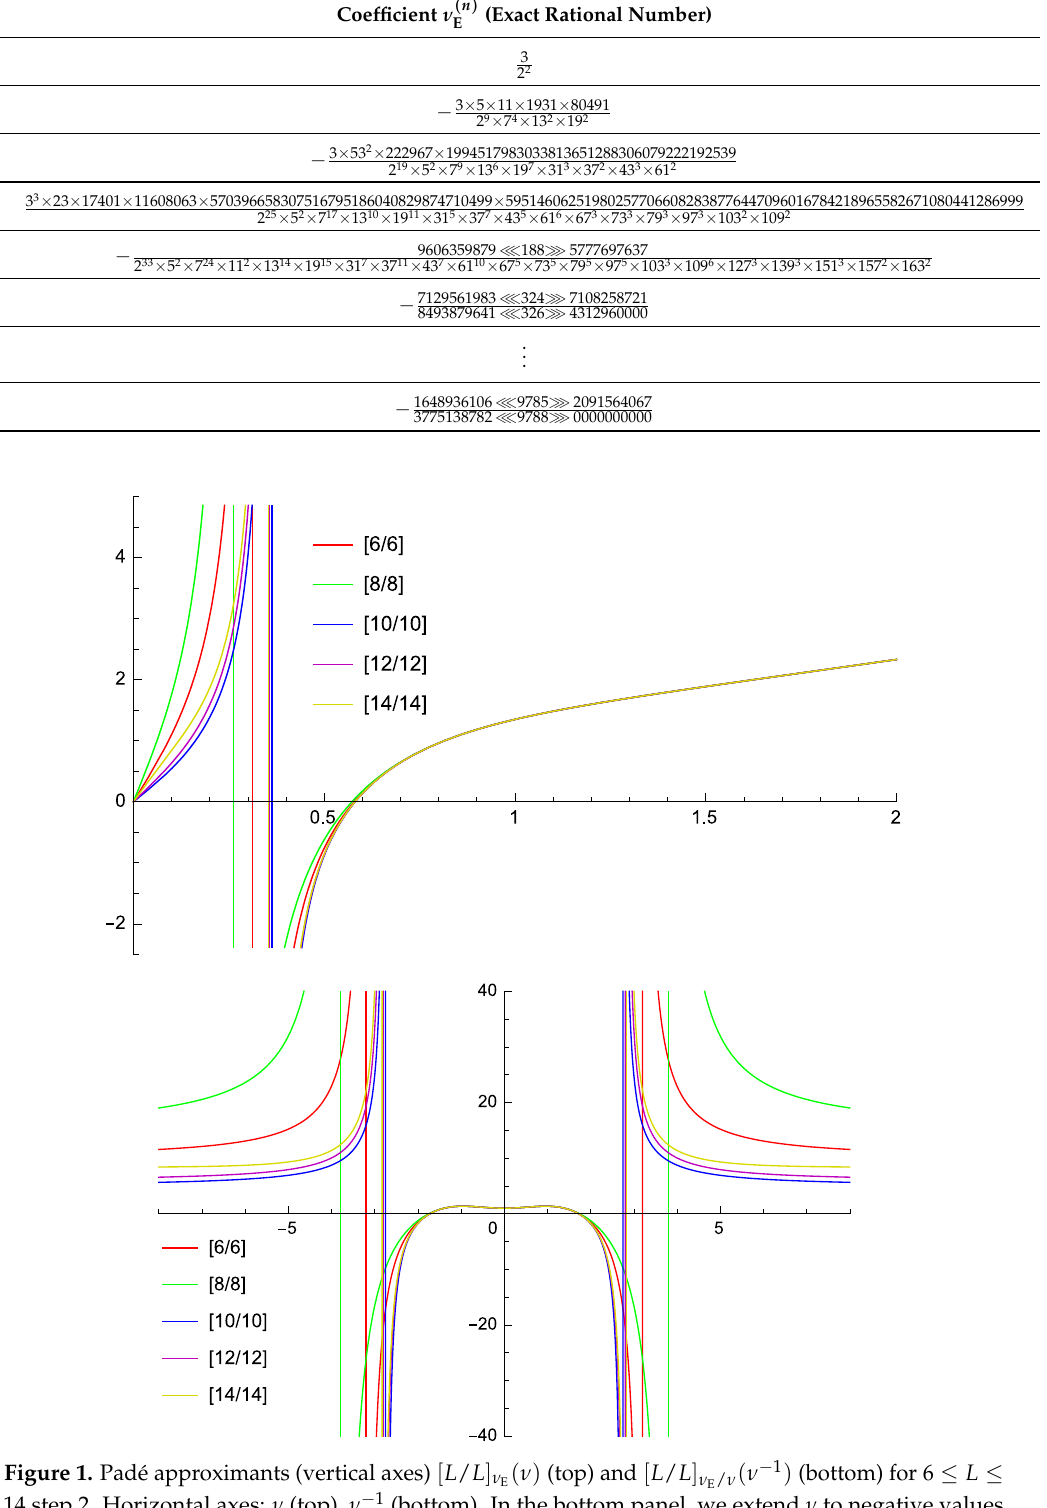
Figure 1. Padé approximants (vertical axes) [ L / L ] ν 14 step 2. Horizontal axes: ν (top), ν − 1 (bottom). In the bottom panel, we extend ν to negative values on purpose to highlight that the Maclaurin expansion of ν E